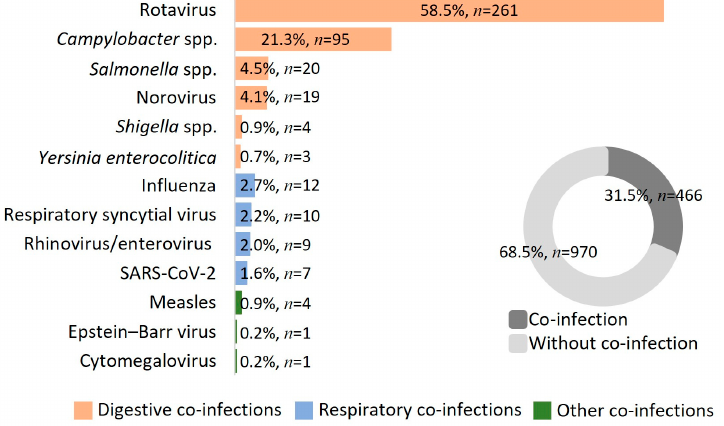
Figure 3. Distribution of co-infections identified in pediatric patients with adenovirus infection.